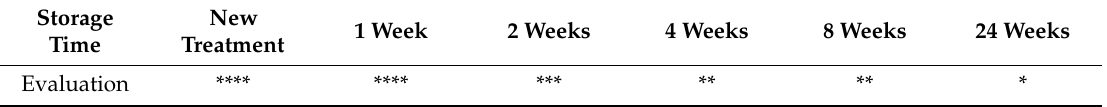
Table 2. Subjective evaluations of the effects of natural fragrance retention on the finished fabrics.